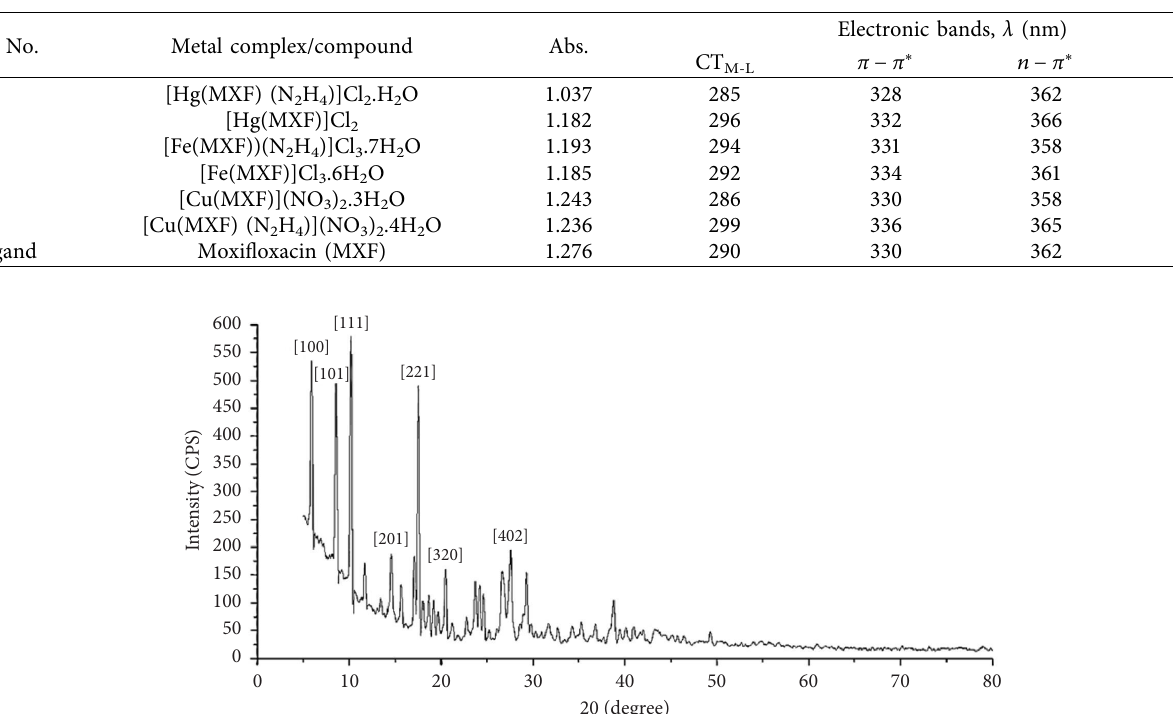
Table 2: Te UV-Vis spectra of ligand moxifoxacin and its metal complexes.